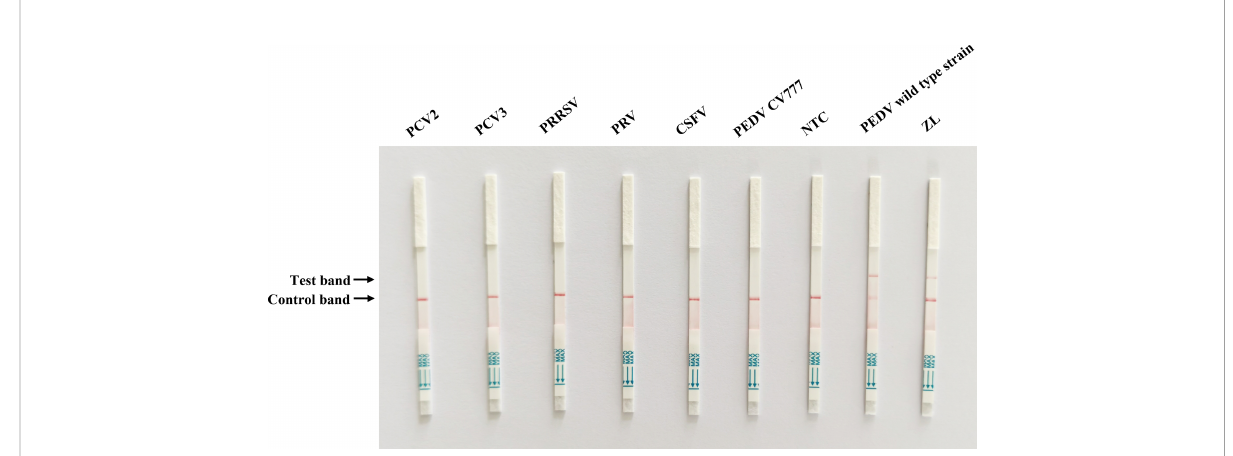
FIGURE 4 Speci fi city test of Cas13a lateral fl ow detection. Porcine circovirus type 2 (PCV2), porcine circovirus type 3 (PCV3), porcine reproductive and respiratory syndrome virus (PRRSV), pseudorabies virus (PRV), classical swine fever virus (CSFV), and PEDV attenuated vaccine strain CV777 were